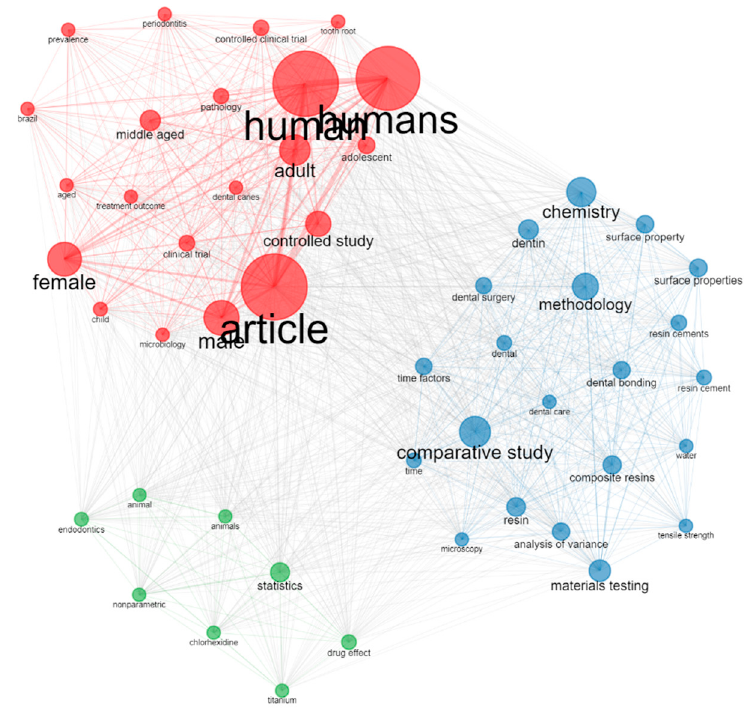
Figure A2. Conceptual Structure. Latin American Dentistry Co-occurrence Network (1996–2020)